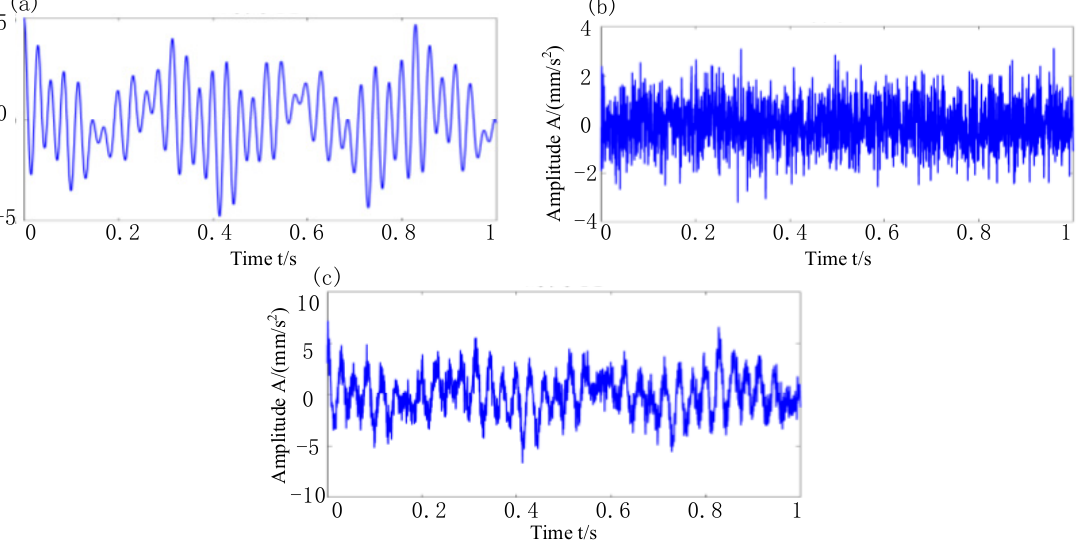
Harmonic components by adapOMP